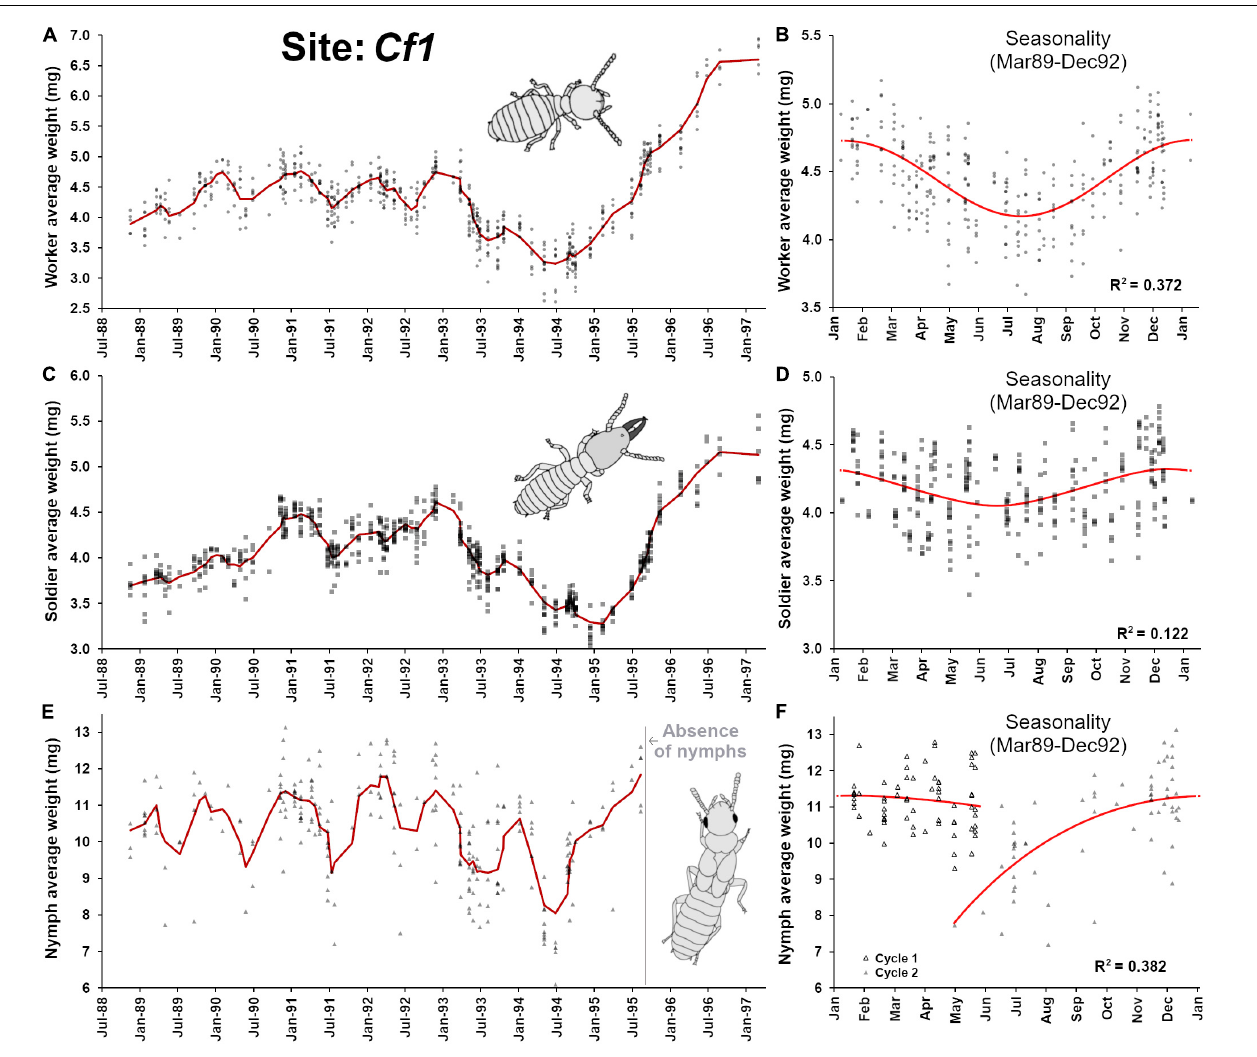
FIGURE 2 | Colony demographic changes for Coptotermes formosanus at site Cf1 . Each data point represents an average caste weight from a field trap. For the 1988–1997 demographic trends of each caste, the red line represents the rolling average function (period = 3) (A) Workers’ average weight between 1988 and 1997. (B) Workers’ average weight seasonality, following an annual sinusoidal function ( F 2 , 307 = 90.73, p < 0.001, R 2 = 0.372). (C) Soldiers’ average weight between 1988 and 1997. (D) Soldiers’ average weight seasonality, following an annual sinusoidal function ( F 2 , 307 = 21.41, p < 0.001, R 2 = 0.122). (E)